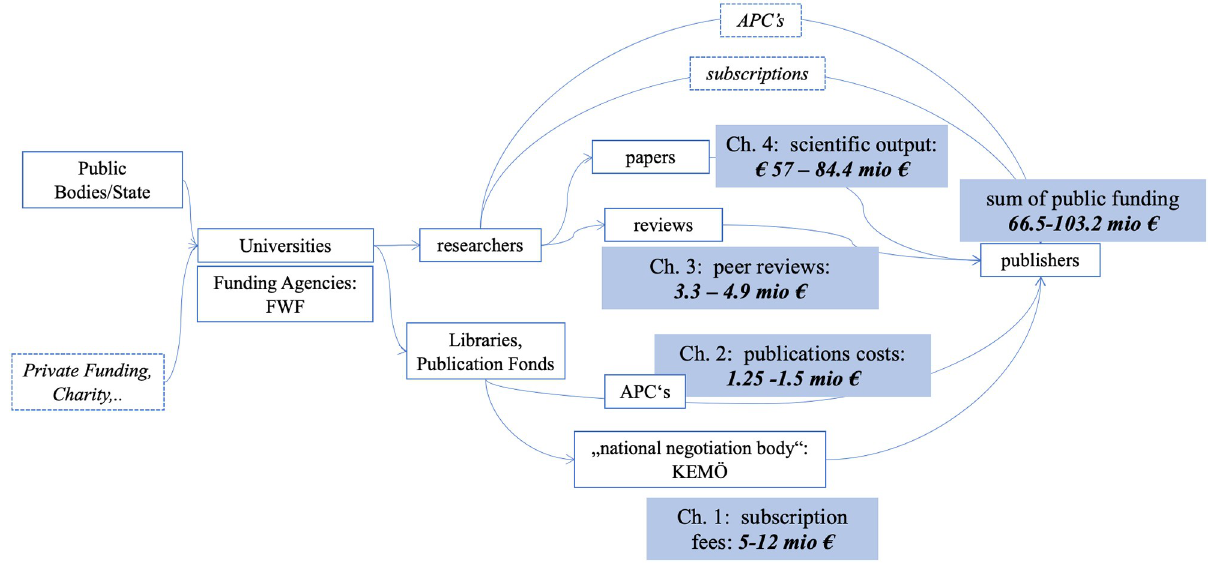
Fig 4. Four-channel-model of access to public funding for academic publishers. An estimation for the social sciences in Austria.